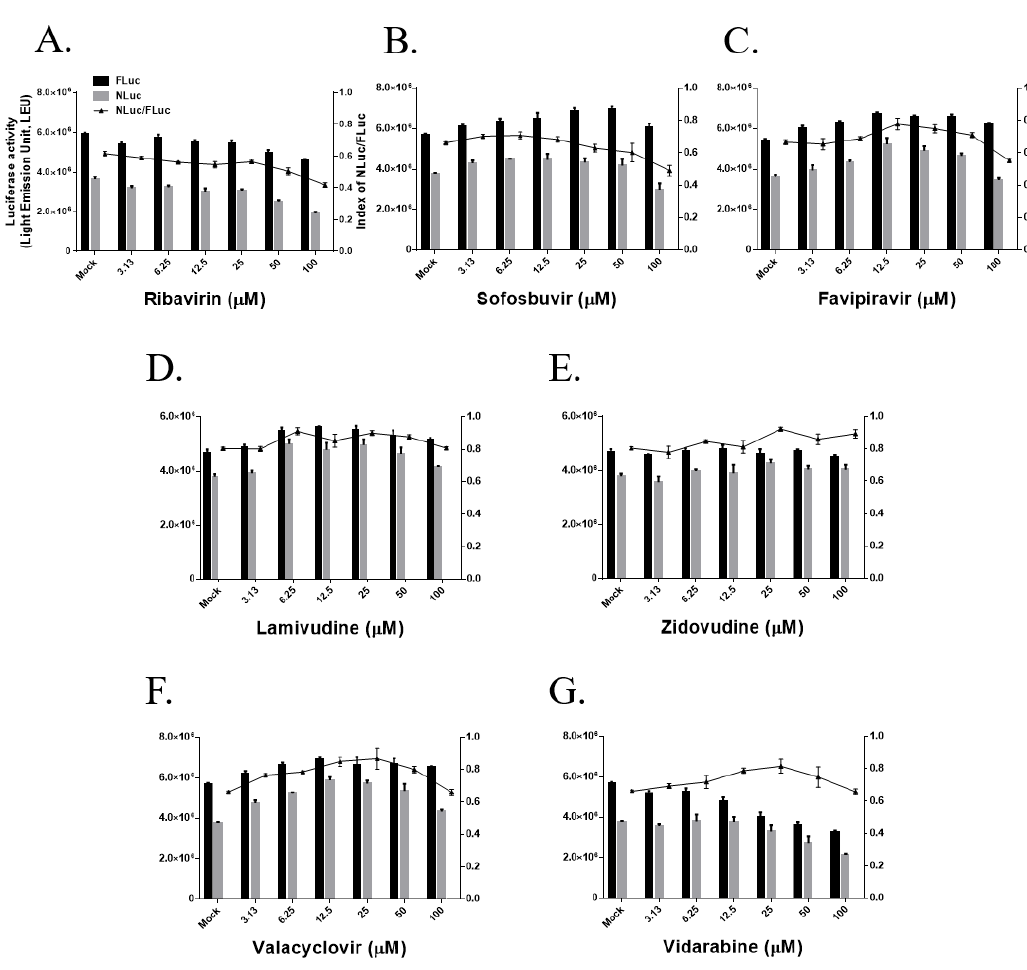
Figure 3. E ff ects of nucleoside / nucleotide analogs on Middle East respiratory syndrome coronavirus RNA-dependent RNA polymerase (RdRp) activity in the cell-based reporter assay system. HEK293T cells were transiently transfected with p( + )FLuc-( − )UTR-NLuc and pN-termFlag-nsp12, and after 6 h, cells were treated with ribavirin ( A ), sofosbuvir ( B ), favipiravir ( C ), lamivudine ( D ), zidovudine ( E ), valacyclovir ( F ), or vidarabine ( G ) at the indicated concentrations for 18 h. FLuc and NLuc